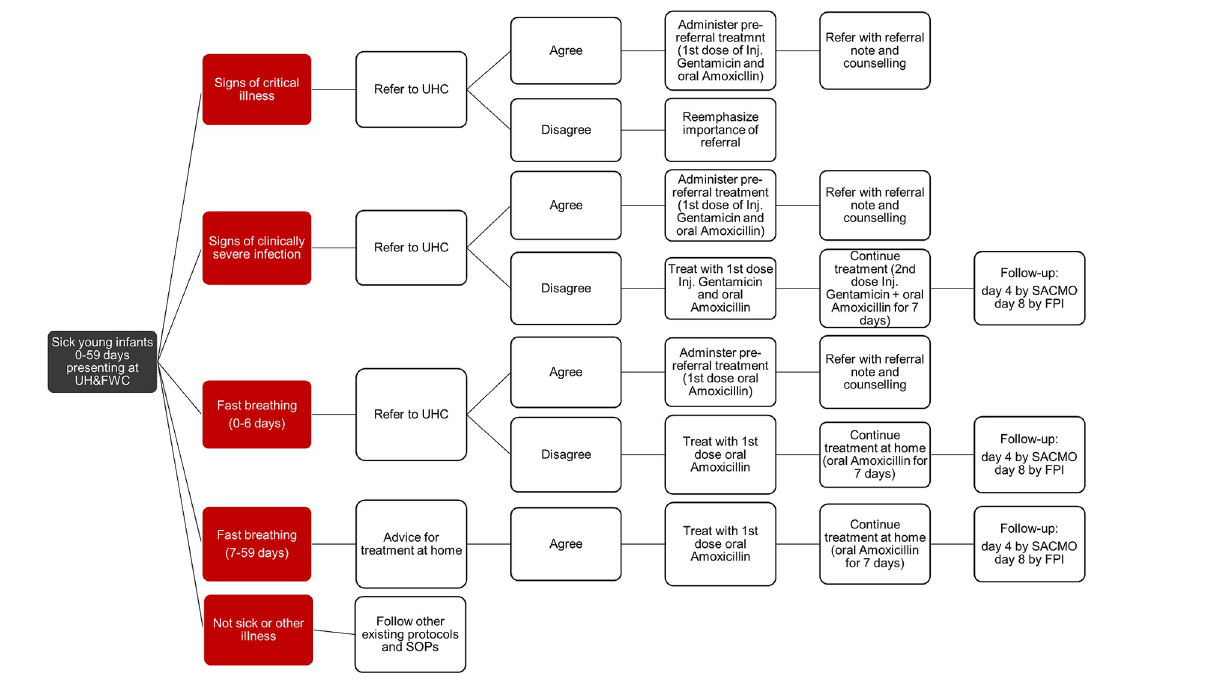
Fig 1. Algorithm of the Bangladesh national PSBI case management guidelines where referral is not